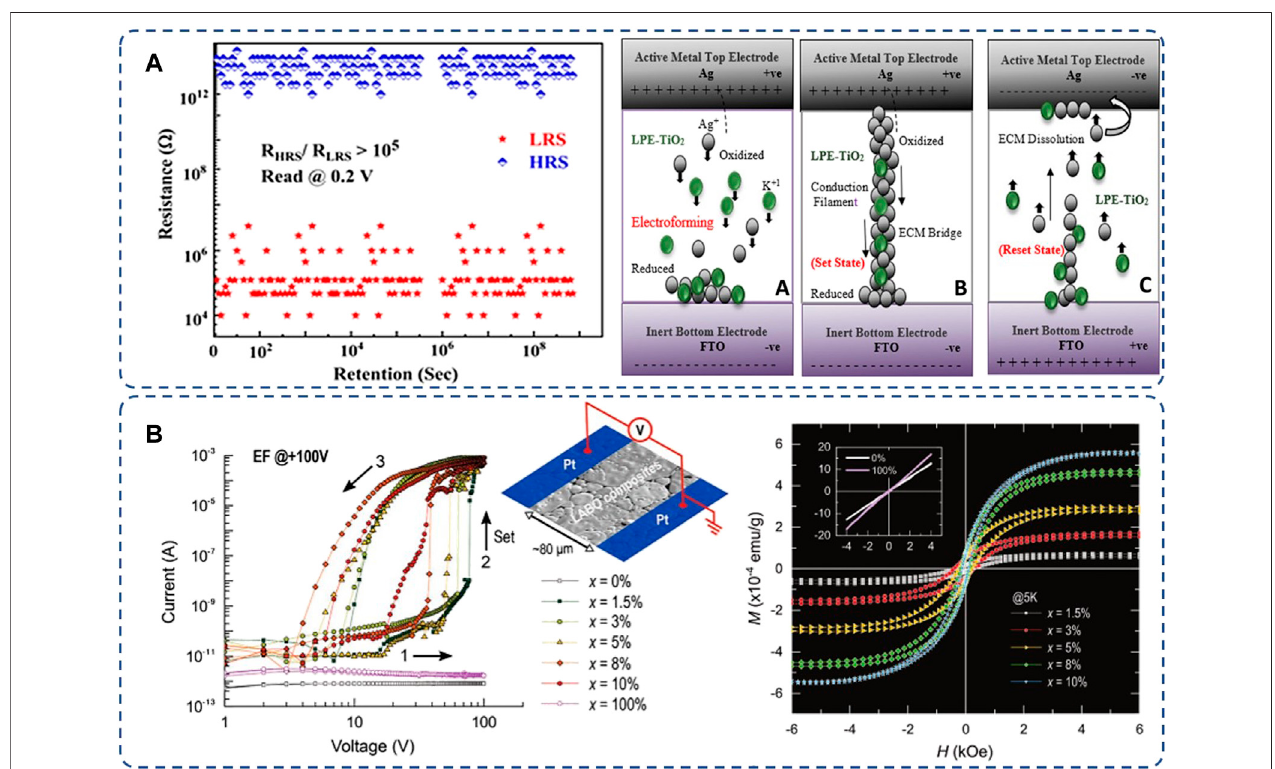
FIGURE 3 | (A) Enhanced retention and the schematic of Ti int assisted the conductive fi lament with Ag + and K + (reproduced with permission (Abbasi et al., 2020). Copyright2020,AmericanChemicalSociety); (B) theremarkablyenhancedRSandferromagneticbehaviorbyB int inLaAlO 3 (1-x):LaBO 3 (x)(reproducedwithpermission (Park et al., 2018). Copyright 2018, John Wiley & Sons,